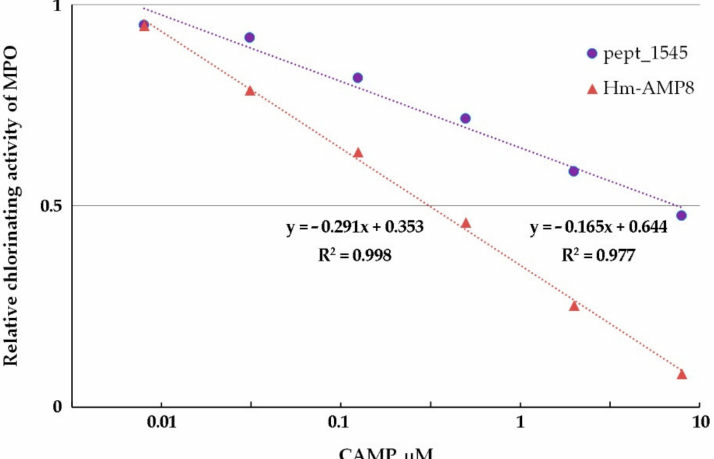
Figure 10. Graphical plot for determination of the half-inhibition concentrations of pept_1545 and Hm-AMP8 for MPO chlorinating activity. The concentrations were as follows: 0.8 nM MPO heme, 200 µ M CB, 150 mM NaCl, and 50 µ M H 2 O 2 in 50 mM Na-acetate buffer, pH